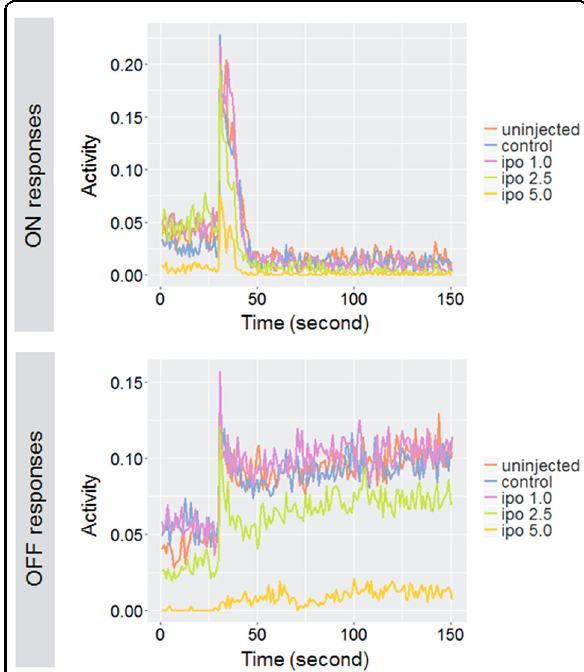
Fig. 5 VMR testing in ipo13 -de fi cient morphants. Larvae injected with ipo13 -MO 5.0 ng show signi fi cantly weaker VMR ON and OFF response on 5 dpf. The responses of the other four groups, including non-injected, control-MO and low concentration ipo13 -MOs, are normal or slightly changed. The y axis represents the burst duration at every second, which indicates larvae activity in response to light ON or OFF. Activities at 30 s before light switch and at 120 s after light switch are represented in the fi